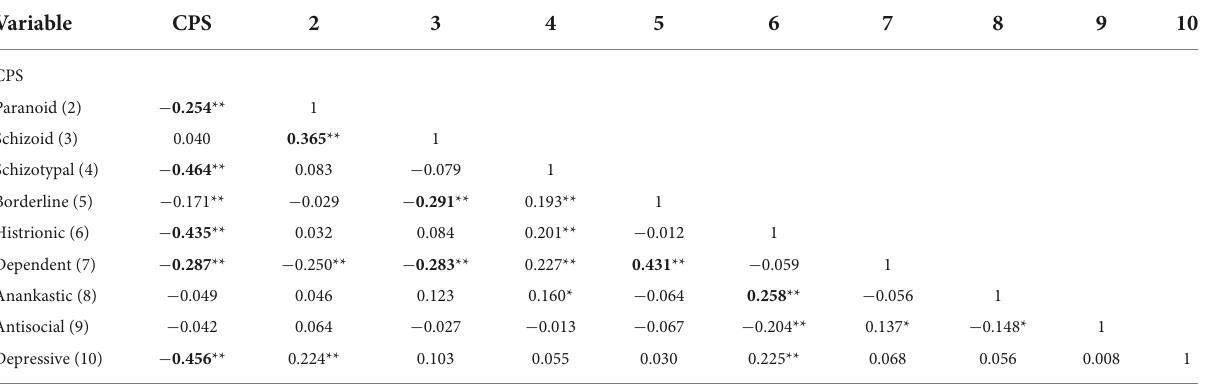
TABLE 3 Correlations between personality traits and CPS